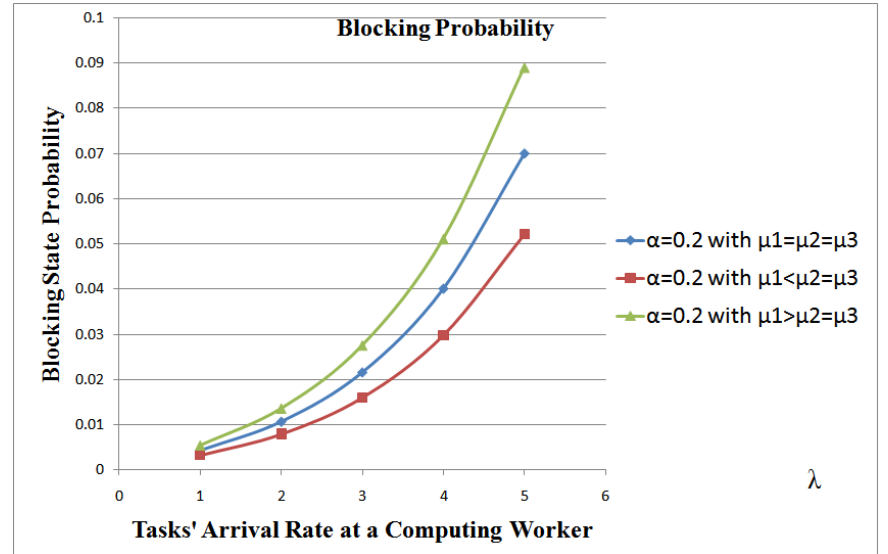
= (cid:22) = (cid:22) 1 ;r 2 ;r 3 ;r